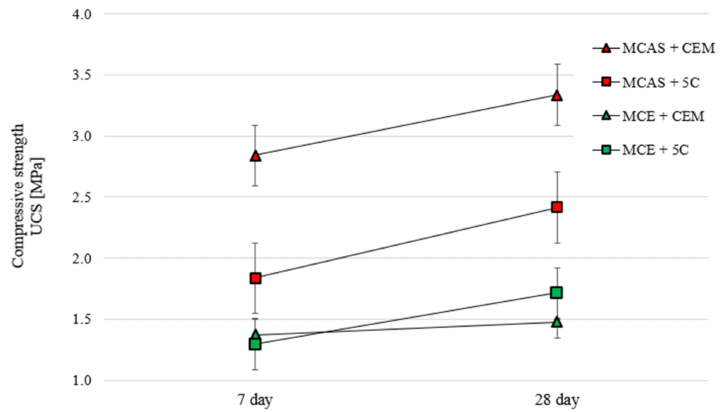
Figure 8. Compressive strength for the cold-recycled mixture (error bars represent standard error).